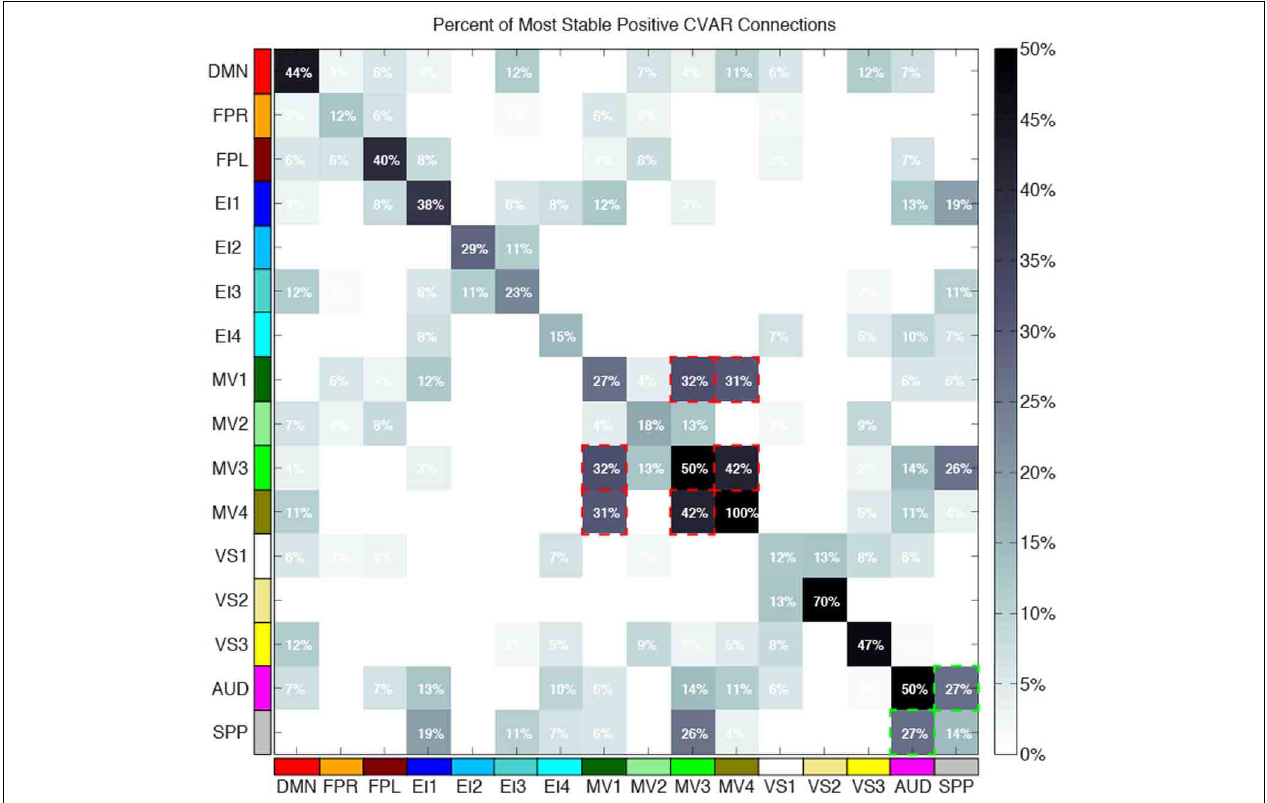
FIGURE 10 | Percentage of within-network (diagonal) and across-network (non-diagonal) most stable positive connections. Two groups of networks with high percentages of across-network connections being temporally stable are highlighted with red (MV1, MV2, and MV3) and green (AUD, SPP) dashed